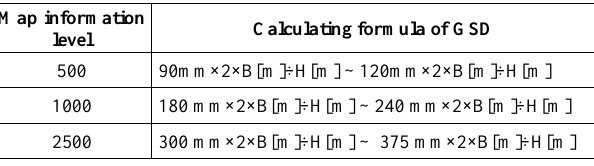
Figure 5. Map information level and corresponding GSD